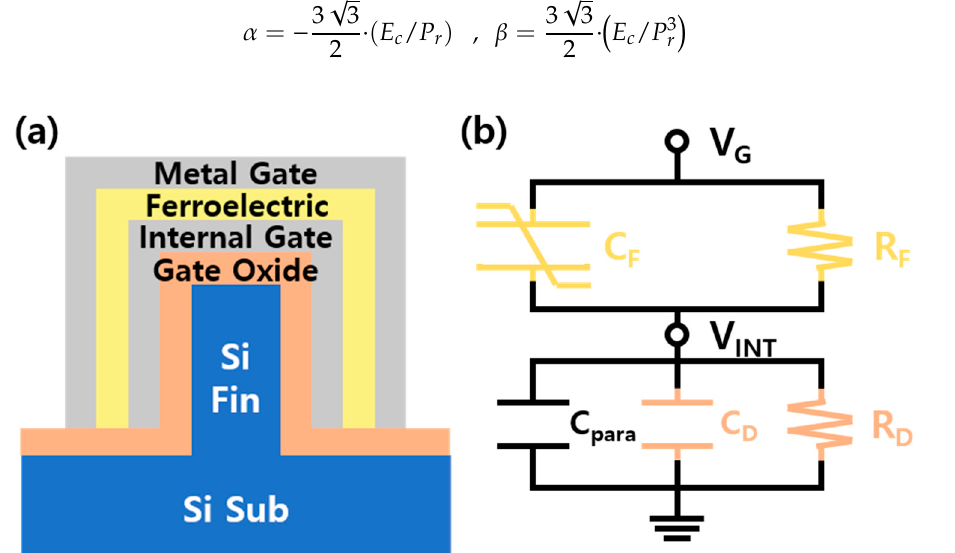
Figure 1. ( a ) Cross-sectional schematic of MFMIS NC FinFET. ( b ) Circuit configuration of MFMIM structure. C D , C F , C para , R F , R D indicates the capacitance of dielectric, ferroelectric layer, and parasitic capacitance; and the resistance of the dielectric and ferroelectric layer, respectively. V G and V INT represents the gate voltage and internal metal voltage, respectively.